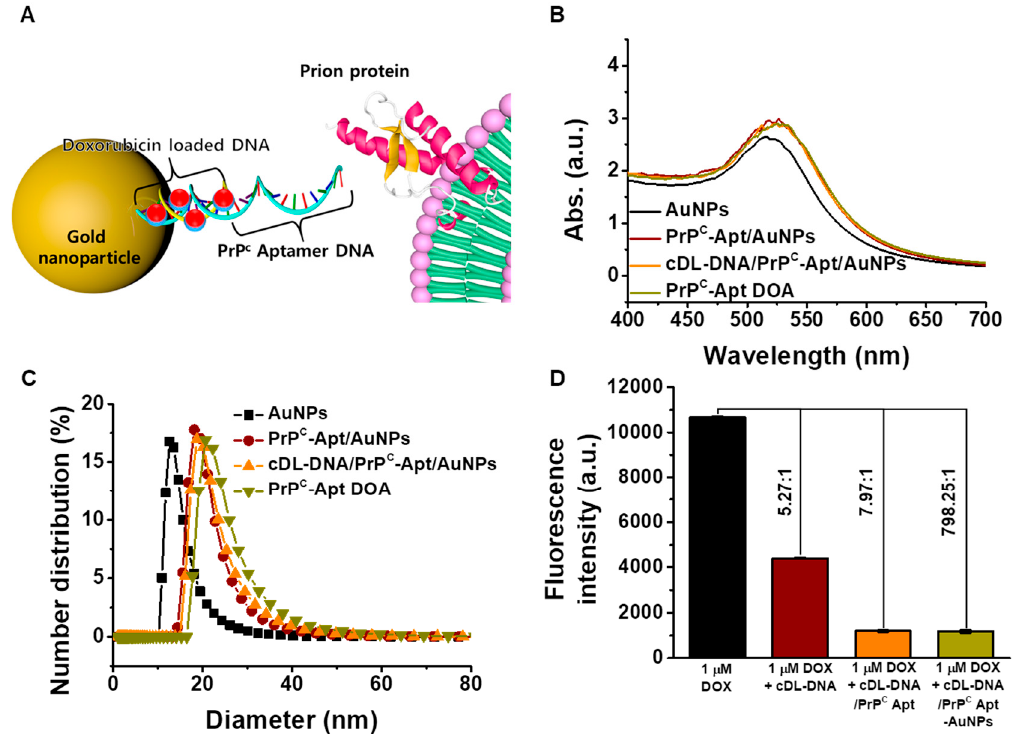
Figure 1. Synthesis and characterization of PrP C -Apt-functionalized doxorubicin-oligomer-AuNPs (PrP C -Apt DOA). ( A ) Schematic diagram of PrP C -Apt DOA. ( B ) UV-Vis spectra of AuNPs at each experimental step ( n = 3). ( C ) dynamic light scattering (DLS) measurements for the hydrodynamic radius of PrP C -Apt DOA at each experimental step ( n = 3). ( D ) Fluorescence measurement for the binding ratios of Dox to cDL-DNA, cDL-DNA/PrP C -Apt, and cDL-DNA/PrP C - Apt/AuNPs ( n =